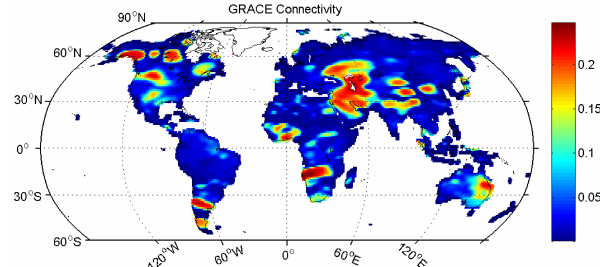
Figure 6. Effect of lagged correlation on GRACE area-weighted connectivity, where the window of lagged correlation is [ − 18, 18]